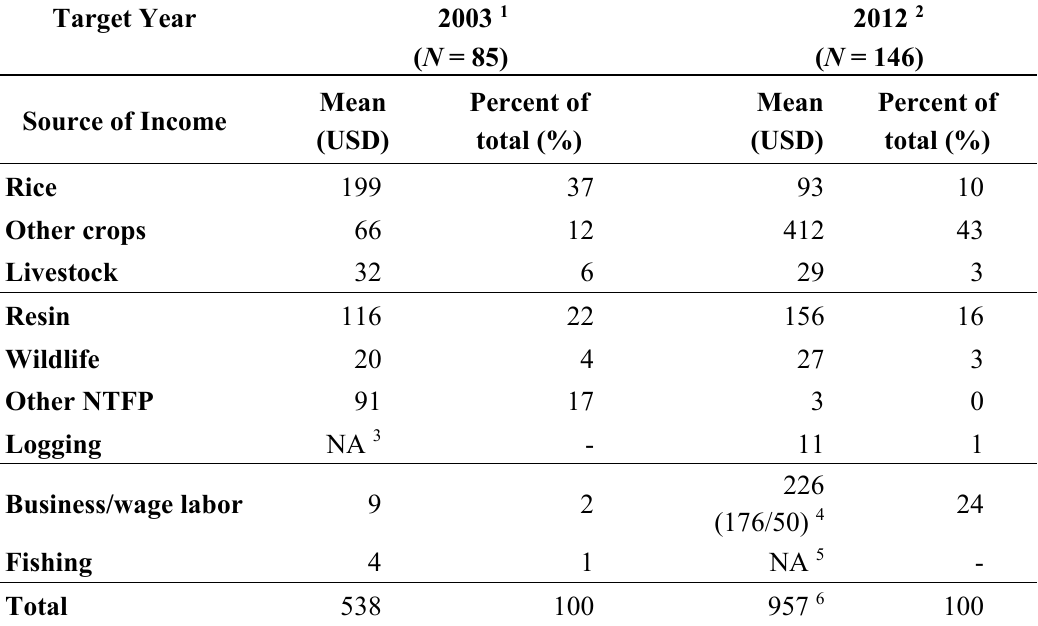
Table 3. Average total HH incomes and income sources in 2003 and